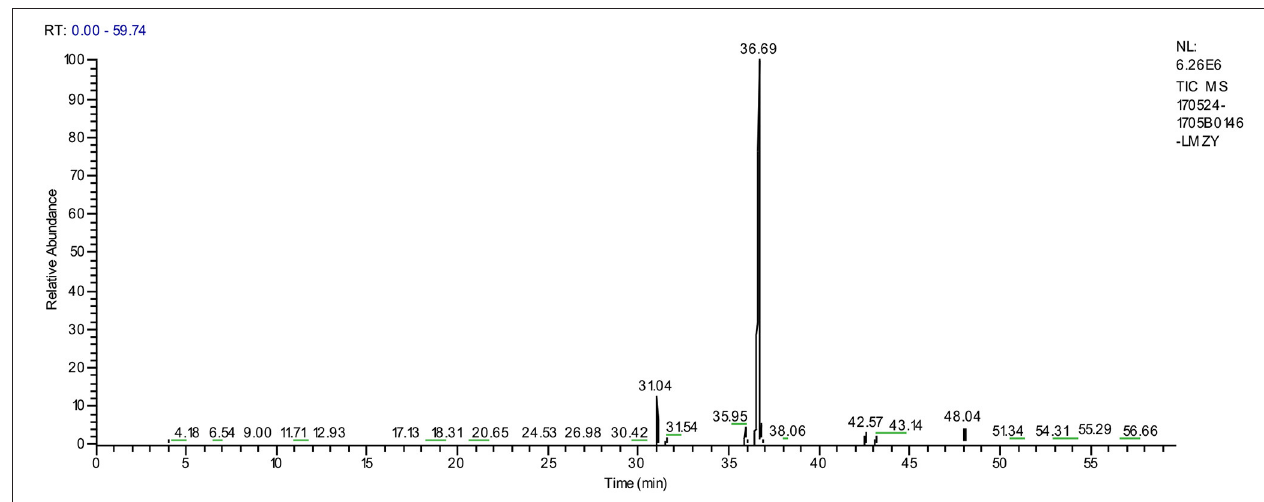
FIGURE 3 | GC-MS total ion chromatogram of Moringa seed